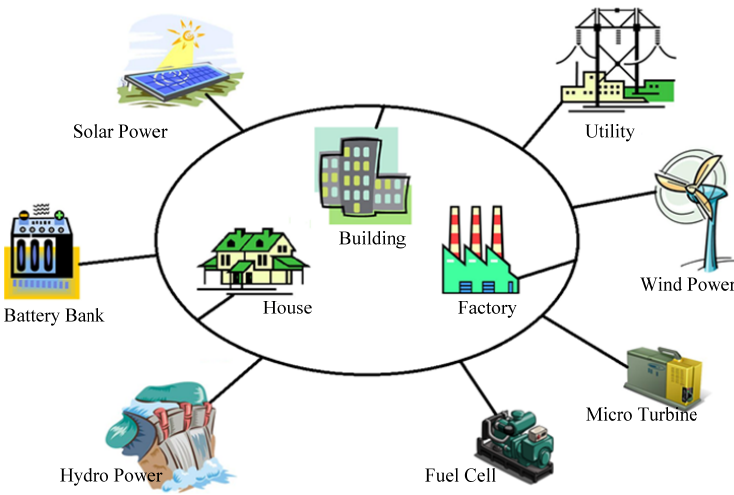
Figure 1. Structure diagram of micro